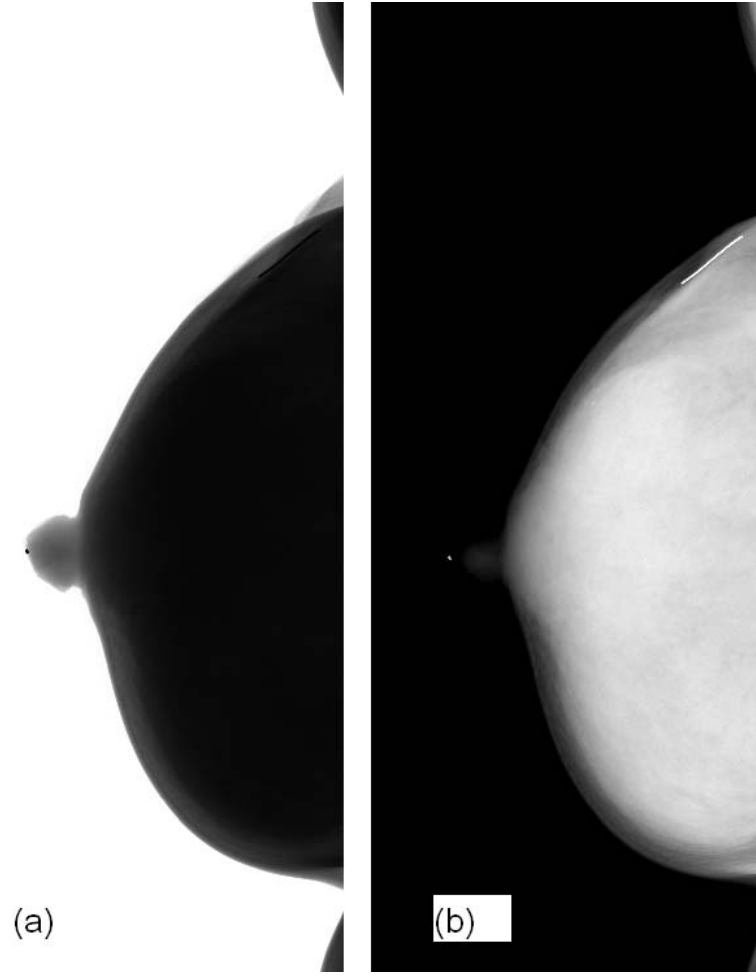
Figure 4. The image before and after ILT. ( a ) The raw image. (Image depth: 14-bit); ( b ) The ILT image (image depth: